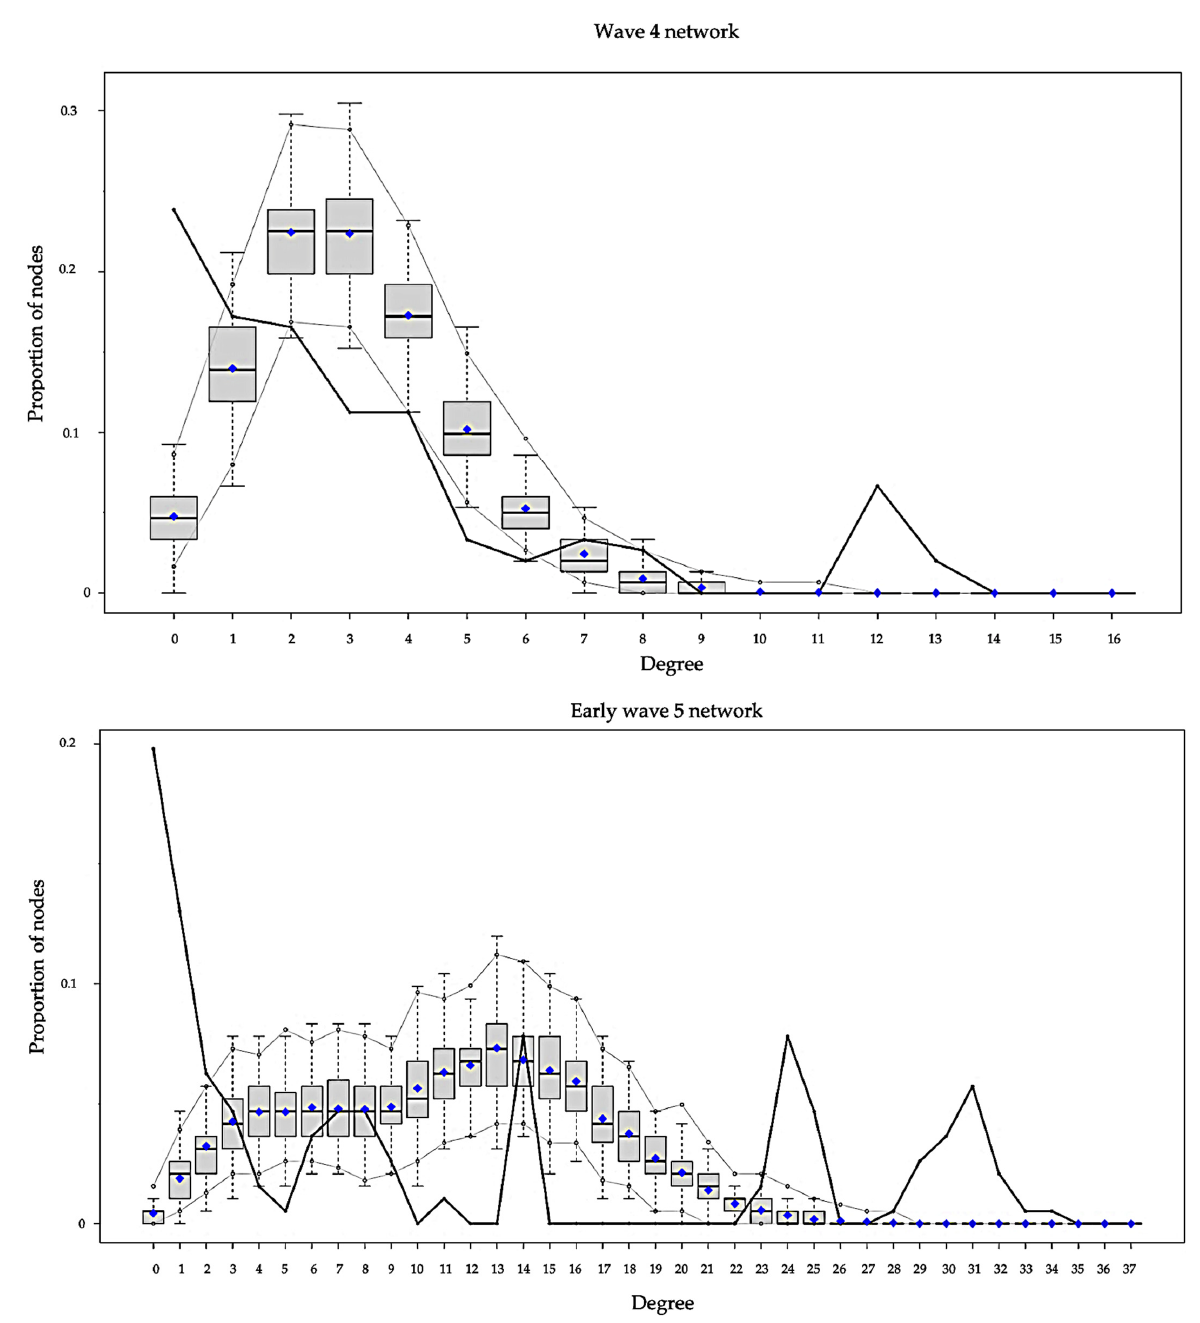
Figure 3. Goodness-of-fit Plots for